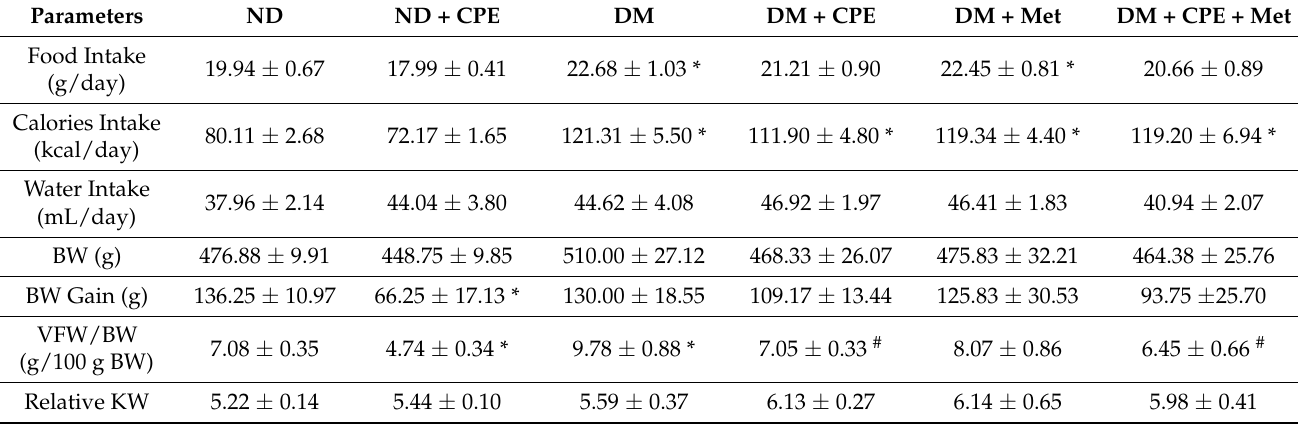
Table 1. Effect of CPE on selected overall nutritional and growth parameters in rats.